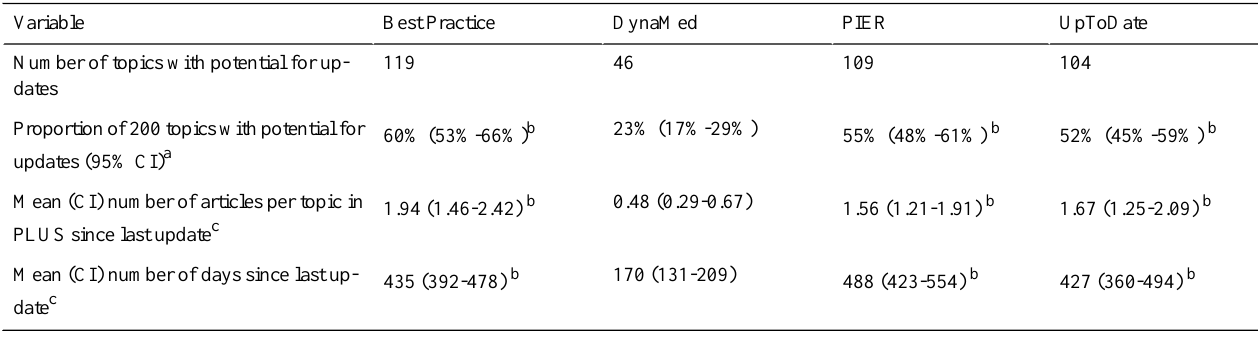
Table 1. Results for 200 equivalent topics across four evidence-based textbooks. UpToDatePIERDynaMedBest PracticeVariable